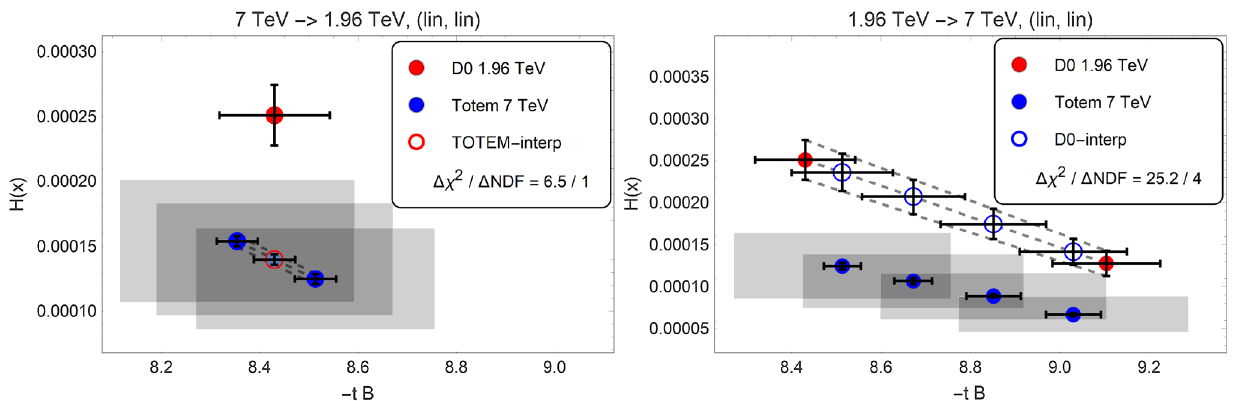
Fig. 14 Left panel indicates the interpolations that are needed for the and a logarithmic vertical scale, as the low x part of the H ( x ) dis- tribution is nearly exponential, that looks like a straight line on such 7 → 1 . 96 TeV projection of the TOTEM H ( x ) scaling function of √ s = 7 . 0 TeV to that of elastic p ¯ p collisions a linear-logarithmic scale. The right panel indicates the projection in elastic pp collisions from √ s = 1 . 96 TeV, taking only one particular point of D0 and the reversed direction: the interpolations during the 1 . 96 → 7 TeV of D0 at projection. In this case, the D0 data do not have type B uncertainties, shown on a linear, linear horizontal and vertical scale. This D0 point hence the shaded boxes are not shown, neither around the D0 points, is in between two nearby TOTEM points, that are interpolated to the nor around their interpolated values. However, between two D0 data- same value of x , including both type A, point-to-point fluctuating ver- points, more than one TOTEM datapoints are measured, so the linear tical and horizontal errors (indicated by vertical and horizontal lines, interpolation is utilized to evaluate the value of the D0 measurement respectively) and type B, point-to-point 100% correlated vertical and at more than one values of x . Due to the larger linear segments in x , horizontal errors, indicated by the horizontal and vertical size of the this method yields larger deviations hence more significant differences shaded boxes around the central values of the data. The plot illustrates between the datasets. To estimate the final significances, we have uti- the lines of interpolations for these central values and the vertical type lized the smallest possible differences, namely linear extrapolations in A errors only, but the vertical type B errors and the horizontal type A the 7 → 1 . 96 TeV on a linear horizontal and logarithmic vertical scales. and B errors are interpolated similarly, using straight line segments, for The partial contribution to the change of χ 2 and N DF is illustrated on a linear horizontal and a linear vertical scale. As part of the systematic checks, the linear interpolation is repeated also for a linear horizontal both